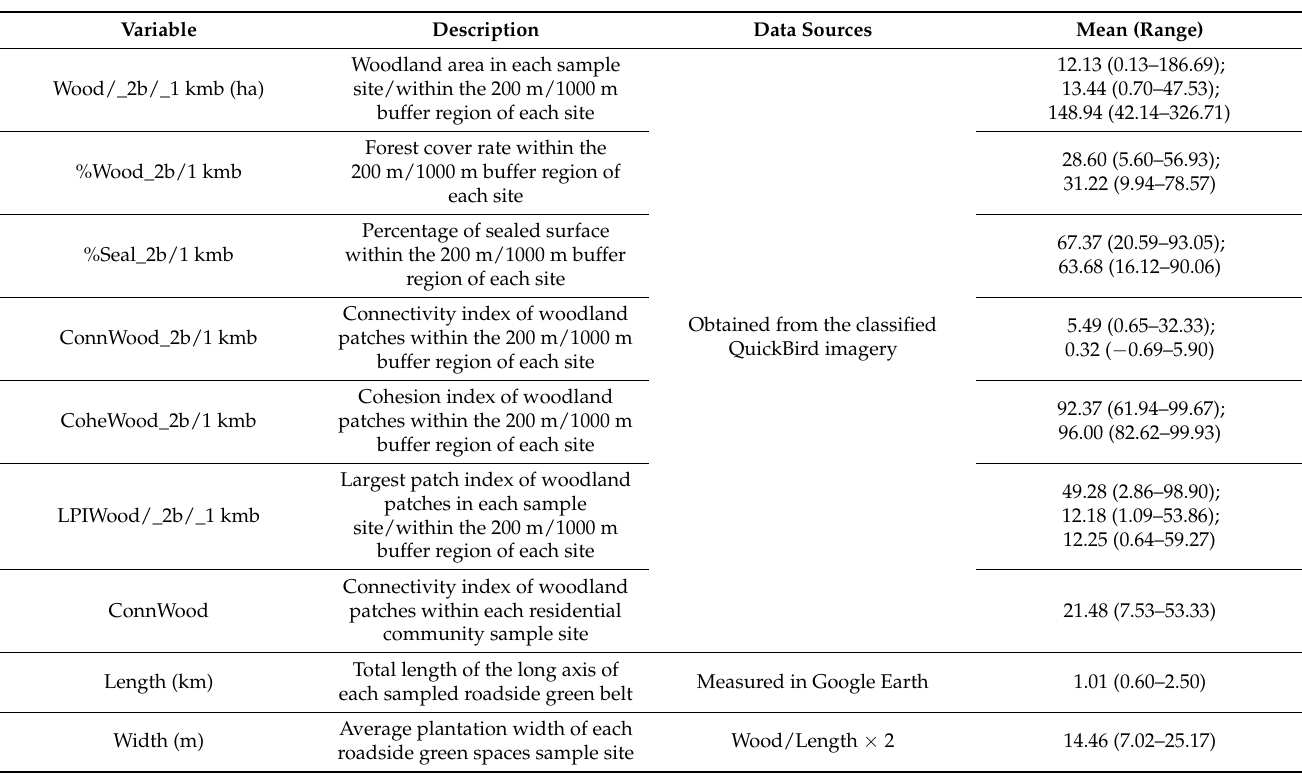
Table 1. Landscape indexes targeting forest bird communities, along with basic